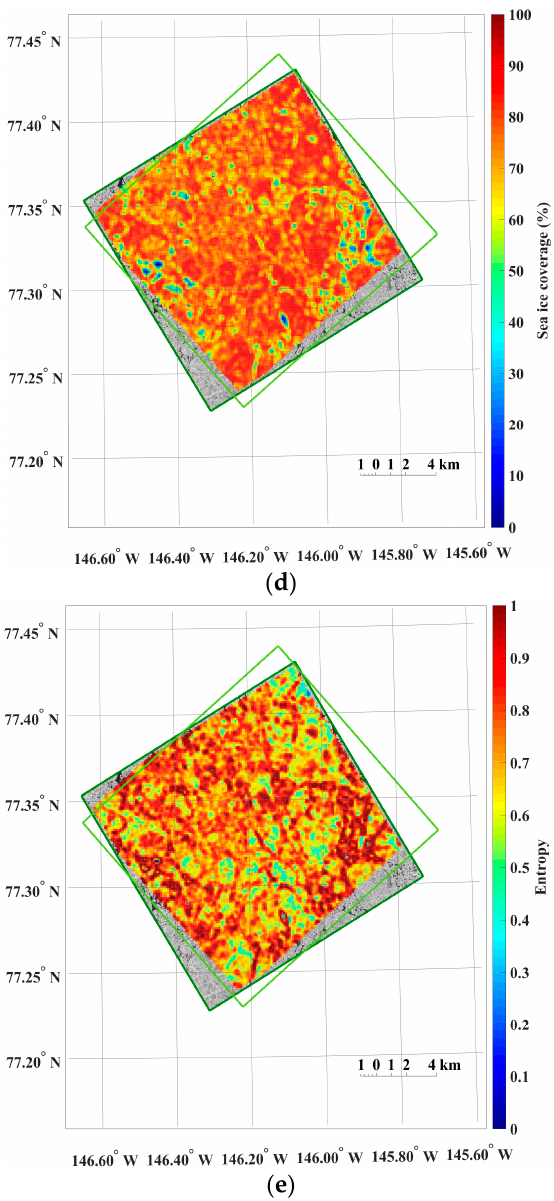
Figure 5. An example of the results from sea ice motion measurement using the KOMPSAT-2 image acquired on 14 August 2014 (i.e., prior image) and the KOMPSAT-3 image acquired on 14 August 2014 (i.e., posterior image), resampled to the spatial resolutions of 4 m: ( a ) magnitudes of the sea ice motion vectors; ( b ) directions (headings) of the sea ice motion vectors, measured counterclockwise from east; ( c ) cross-correlation coefficient of each image block; ( d ) sea ice coverage of each image block in the prior image; and ( e ) entropy of each image block in the prior image, plotted only for the image blocks after applying the cross-correlation coefficient threshold and outlier removal.